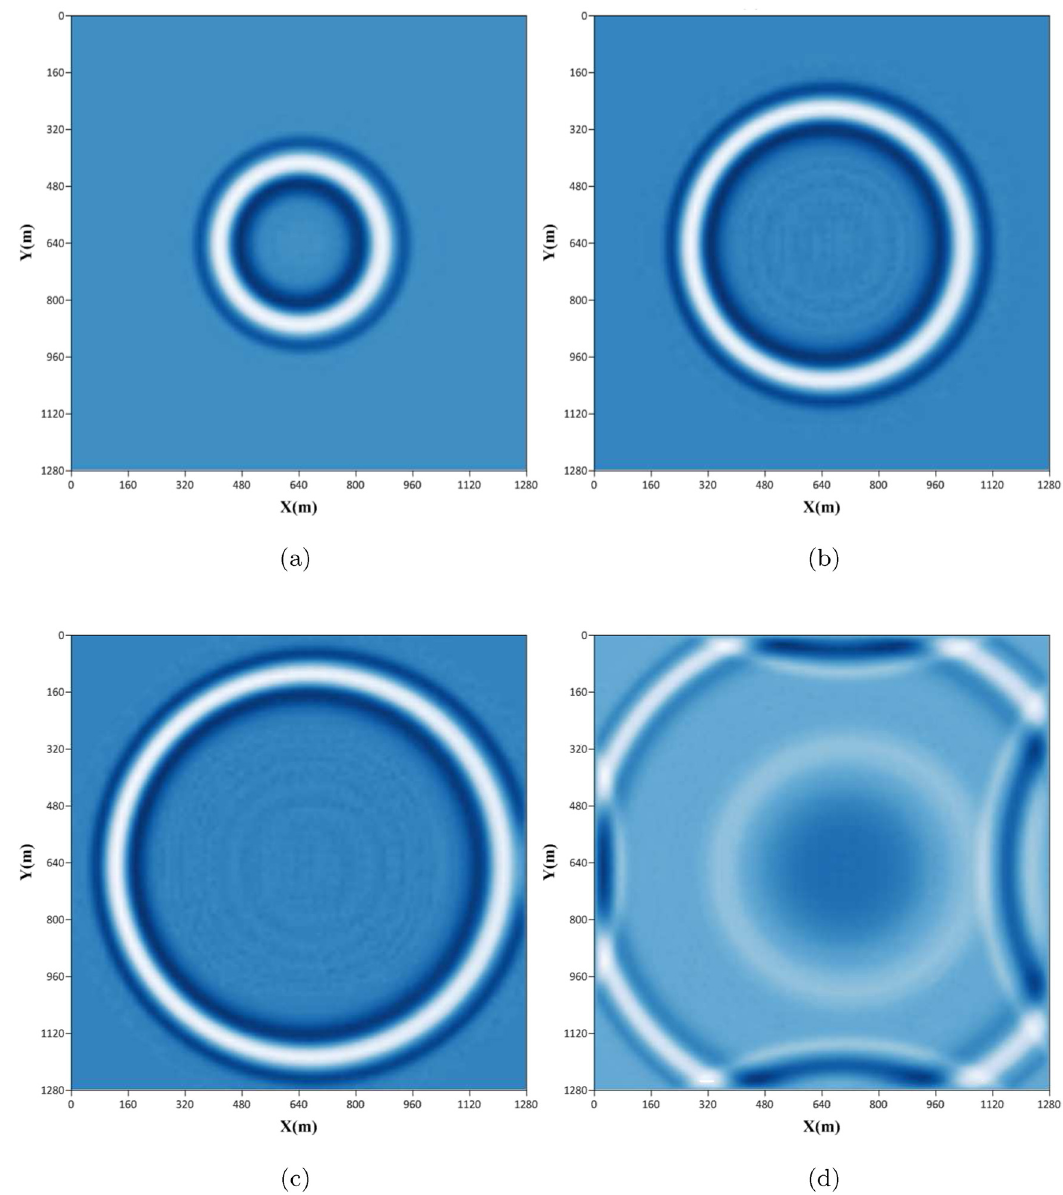
Figure 2: Wave fi elds snapshots: ( a ) Z - section at = t 0.2 s , ( b ) Z - section at = t 0.3 s , ( c ) Z - section at = t 0.4 s , and ( d ) Z - section at = t 0.5 s